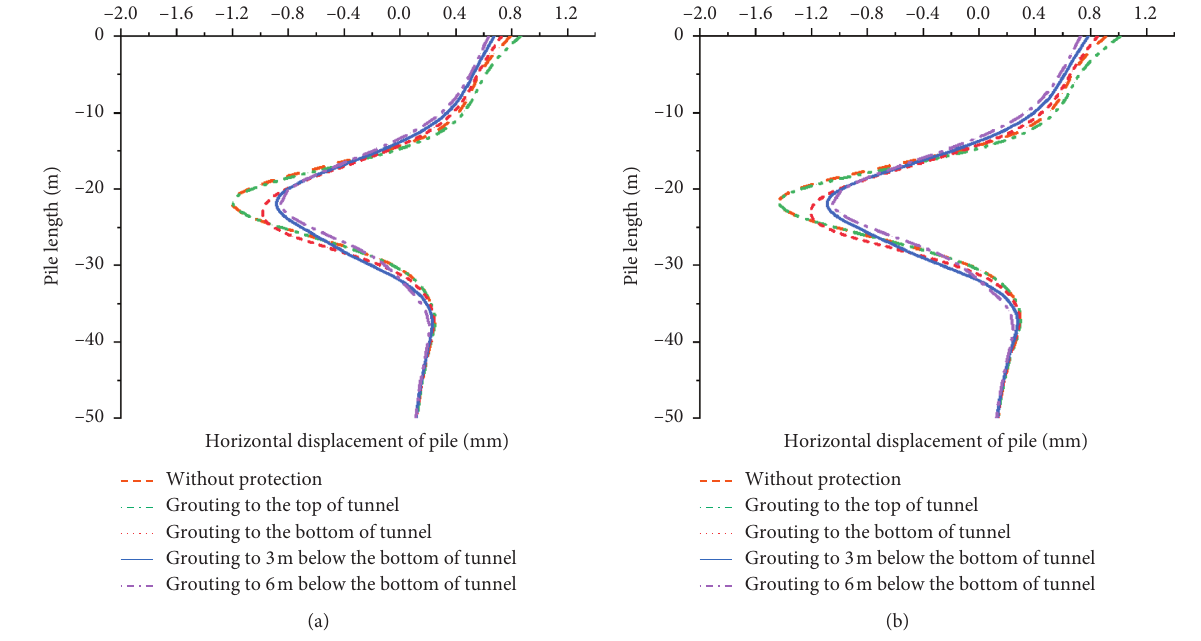
Figure 12: Horizontal displacement of the pile: (a) 2 rings after passing the pile; (b) 4 rings after passing the pile.